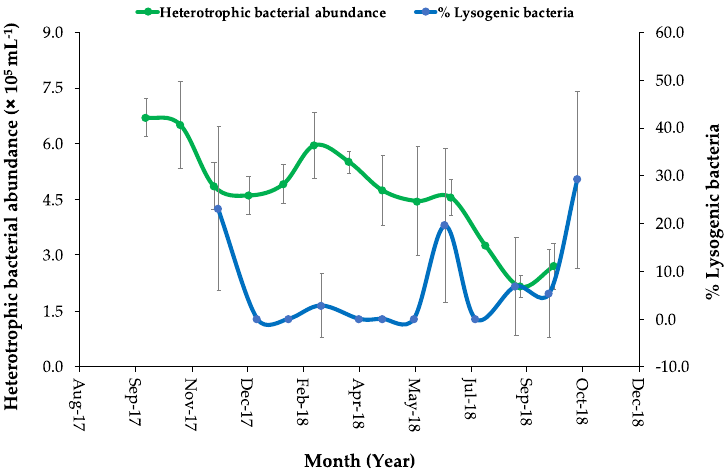
Figure 5. Percentages of lysogenic bacteria (blue line and dots) and bacterial abundance (green line and dots) quantified in the natural microbial communities of the coastal Red Sea lagoon (December 2017 to October 2018). The vertical bars encompassed the error bars. The error bars of the bacterial abundances were generated from two replicates. The error bars of lysogenic bacterial percentage were calculated for only the detectable lysogeny proportion.